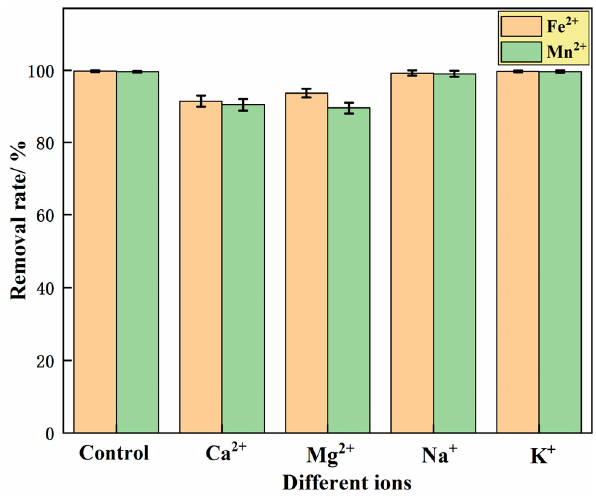
Figure 5. The effect of co-existing ions on the Fe 2+ and Mn 2+ removal effect.